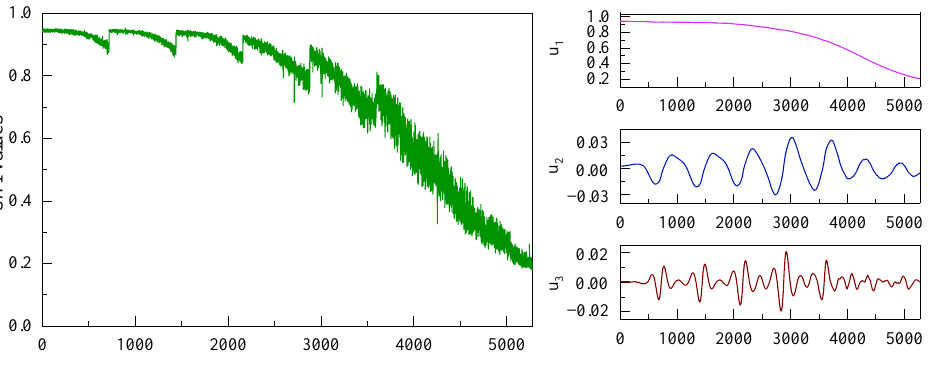
Figure 9. Decomposition of SHI.